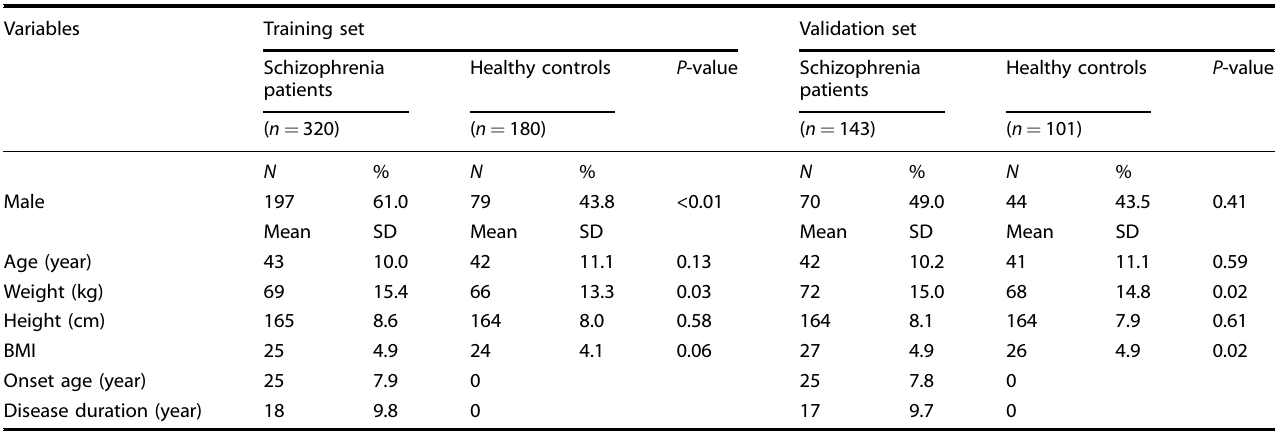
Table 1. Characteristics of participants in the training and validation sets.